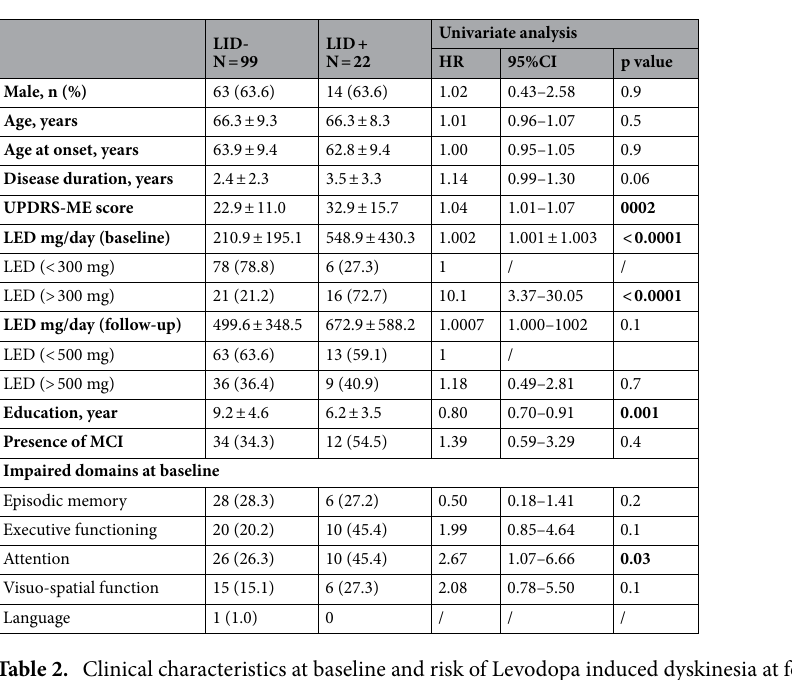
Table 2. Clinical characteristics at baseline and risk of Levodopa induced dyskinesia at follow-up. LID: levodopa induced dyskinesia; UPDRS-ME: Unified Parkinson’s Disease Rating Scale-Motor Examination; LED: levodopa equivalent dosage; MCI: mild cognitive